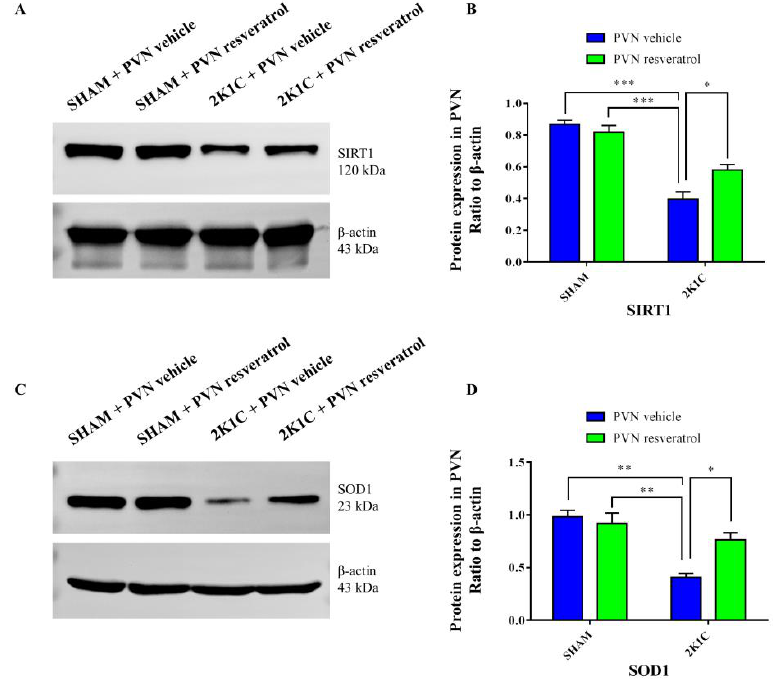
Figure 3. The effects of resveratrol on SIRT1 and SOD1 protein expression in PVN. ( A ) Representative immunoblots of SIRT1 and β -actin; ( B ) densitometry protein expression of SIRT1; ( C ) immunoreactive bands of SOD1 and β -actin; and ( D ) statistic of SOD1 protein expression. Values are the mean ± SEM. * p < 0.01, ** p < 0.01, *** p < 0.001, n = 3.